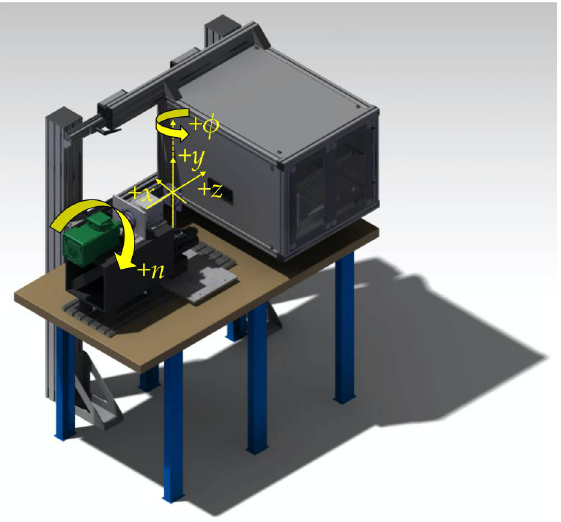
Figure 15. Coordinate system, tilt angle and rotational speed applied during the sensor system tests. The speed is defined as positive clockwise from +z view and the tilt angle positive clockwise from bottom view ( +y ).